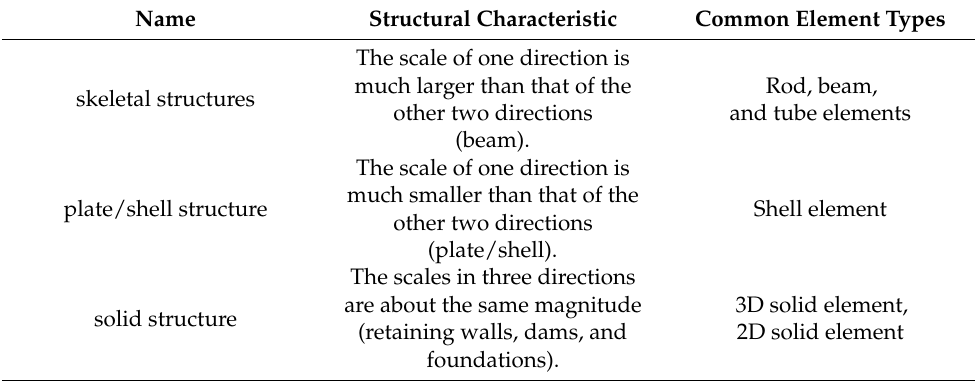
Table 5. Characteristics and three types of